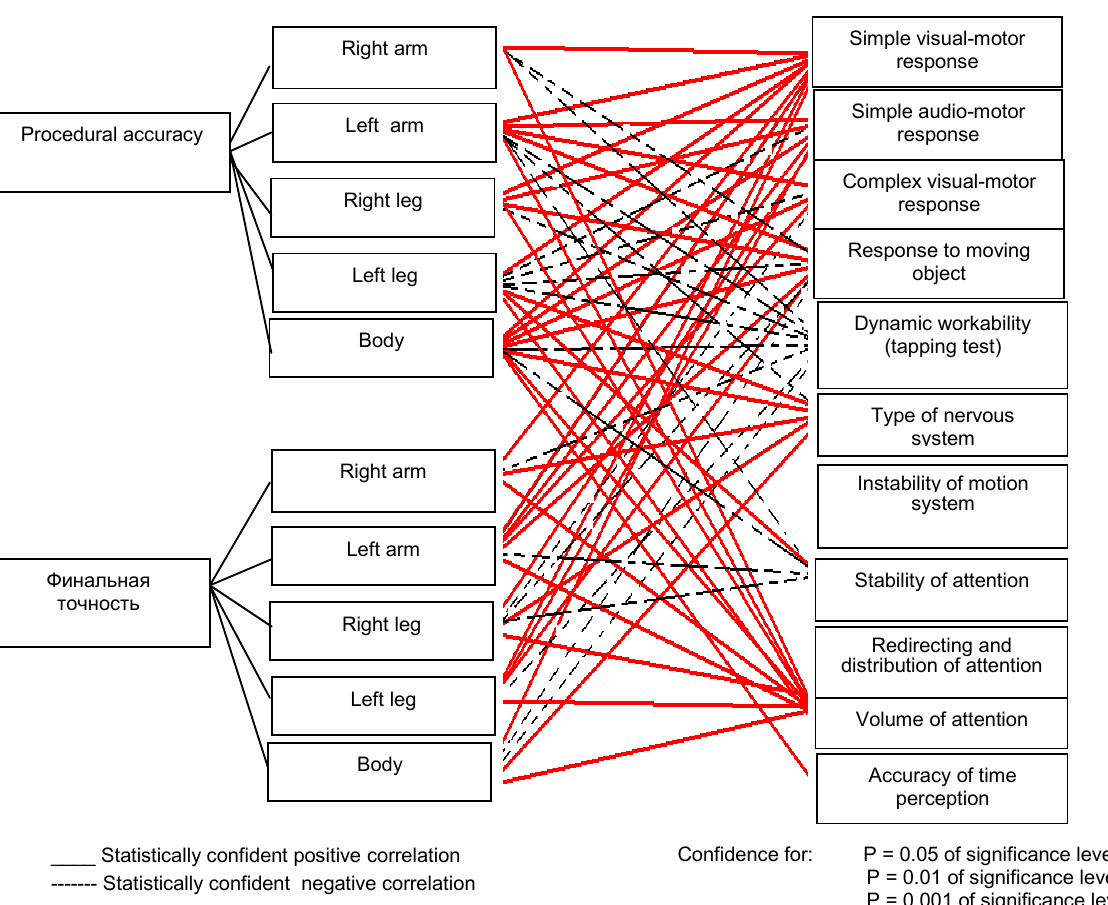
Fig.1. Correlation structure of psycho-motor abilities and space-time parameters of procedural and final accuracy